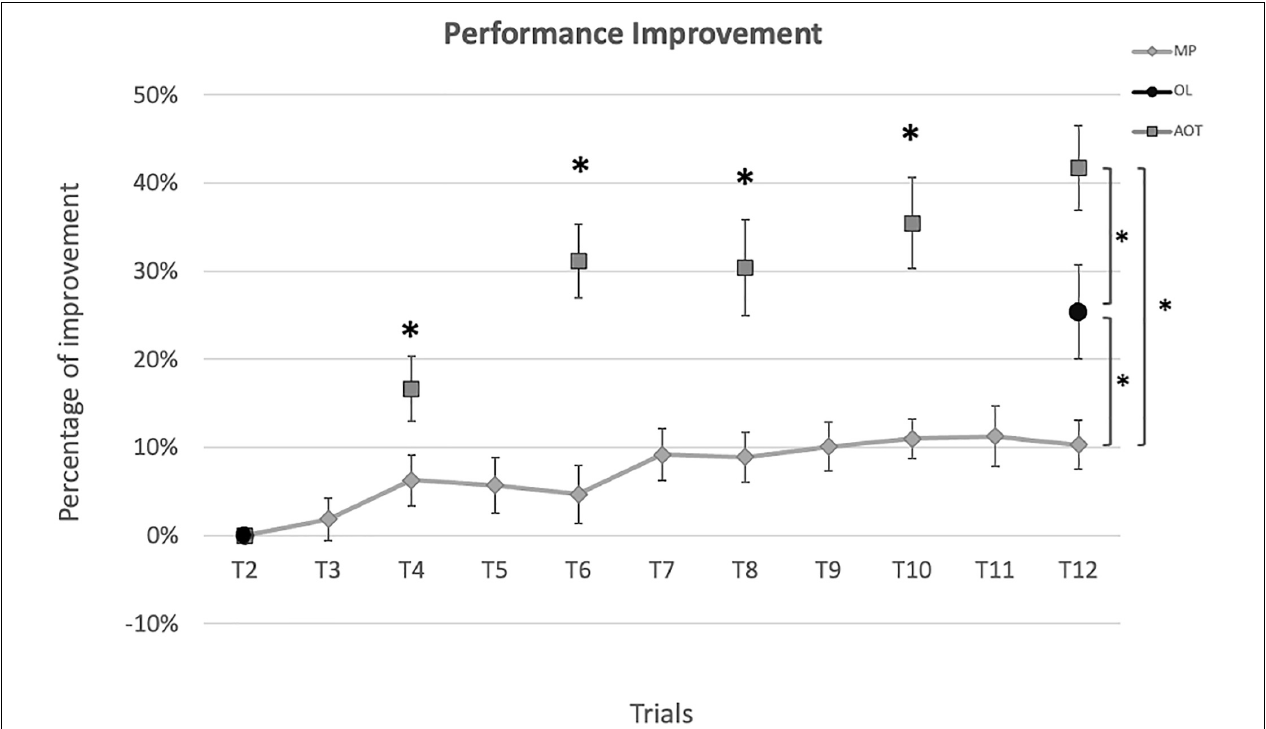
FIGURE 3 | Performance improvement. Performance improvement (%) evaluated at each execution trial relative to the baseline. Diamonds represent the motor practice (MP) scores, circles represent the observational learning (OL) scores, and squares represent the action observation training (AOT) scores. Asterisks indicate significant differences at the Mann-Whitney test ( p <